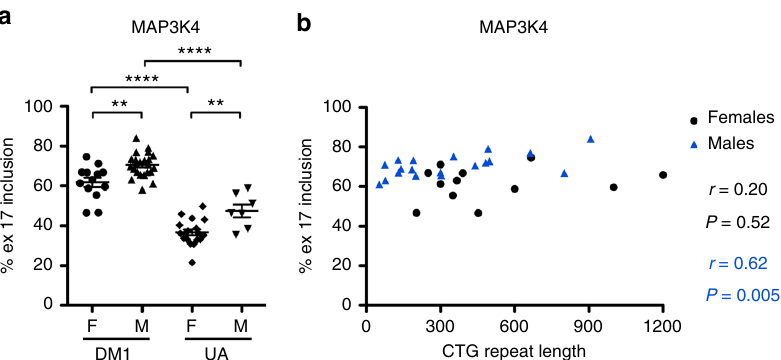
Fig. 7 Alternative spicing patterns in urine exRNA samples vs. biologic sex and CTG repeat length. a MAP3K4 exon 17 inclusion in females vs. males with DM1 and UA groups. Error bars indicate mean ± s.e.m. **** P < 0.0001 DM1 females vs. UA females and DM1 males vs. UA males; ** mean difference 8.7, 95% CI of difference 2.0 – 15.3 (DM1 females vs. DM1 males) and mean difference 10.9, 95% CI of difference 2.3 – 19.4 (UA females vs. UA males). b MAP3K4 exon 17 inclusion vs. DMPK gene CTG repeat length in females (black) and males (blue) with DM1. The correlation coef fi cient r and P values